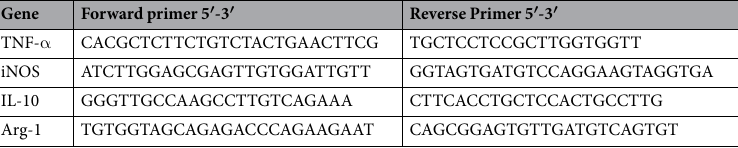
Table 1. Sequences of primers used for real time qPCR